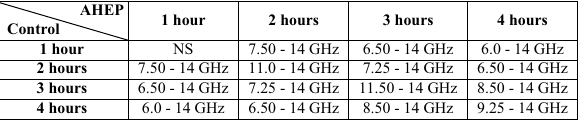
Table 2. Pairwise comparison for in vivo data at one-hour time interval. Table show the frequency ranges where statistical significance were found in each hourly pairwise comparison, between livers in the control group and the AHEP group (Comparison between two different groups). “ NS ” = “Not Significant”, “ N/A ” = “Not